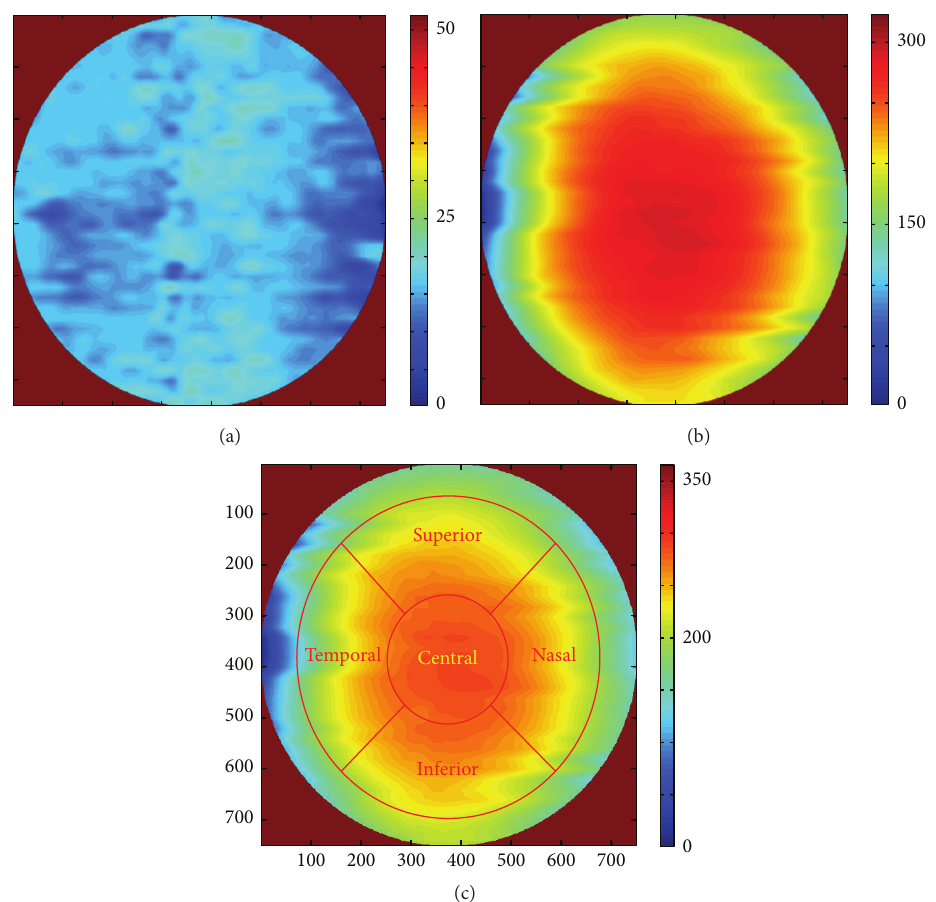
Figure17: 3Dthicknessmapsofanormalsubject.(a)Wholecornea;(b)layer1;(c)thelayercreatedbyBowmanandEndotheliumboundaries (the zones are defined in concentric circles with diameters equal to 2 and 5 millimeters, as central, superior, inferior, nasal, and temporal